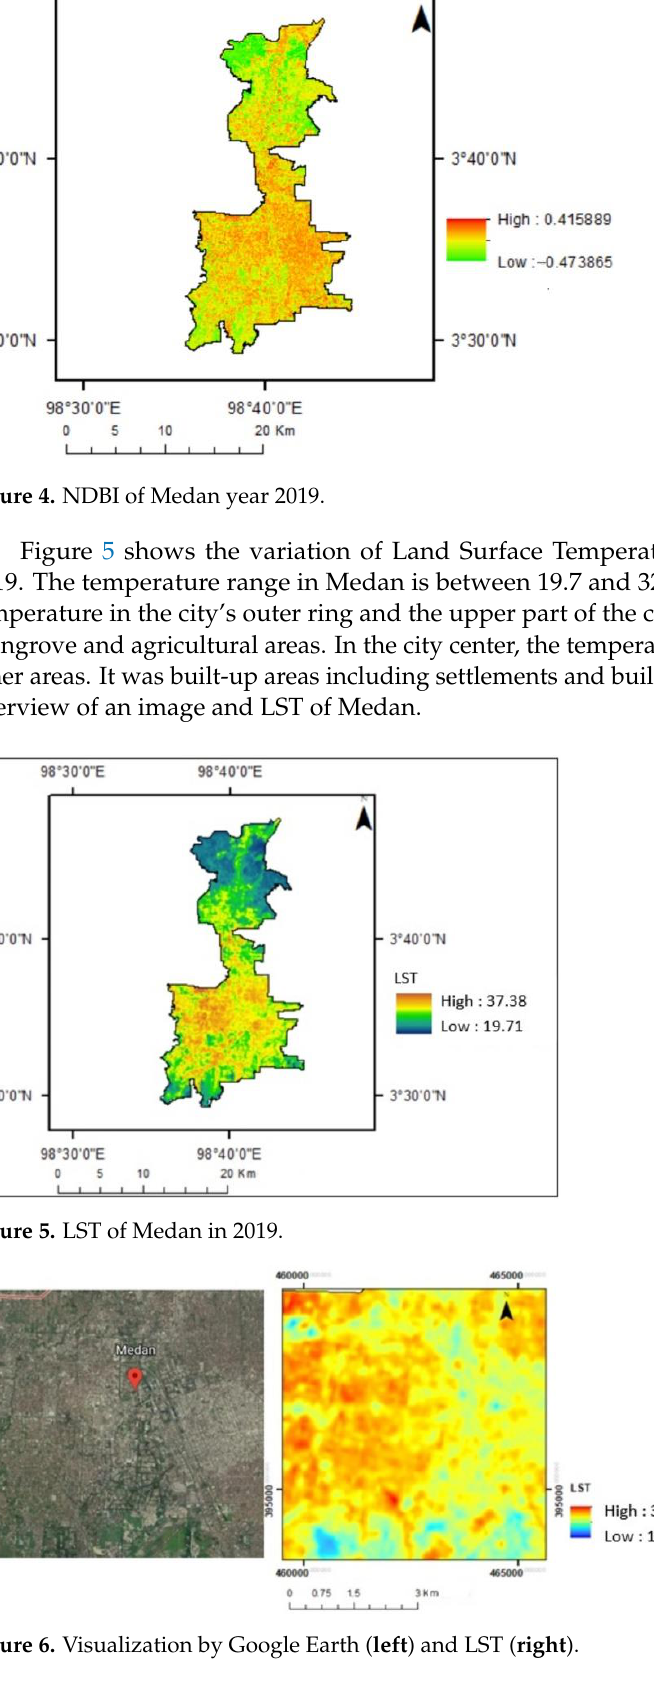
Figure 6. Visualization by Google Earth ( left ) and LST ( right ).